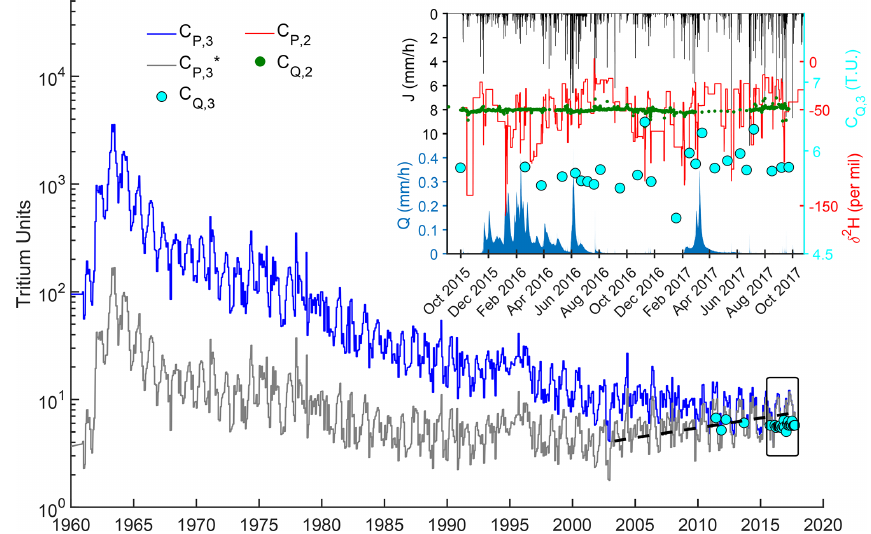
Figure 2. Data used in this study – 3 H in precipitation ( C P , 3 ), the corresponding tritium activities accounting for radioactive decay un- til 2017 ( C ∗ ), δ 2 H in precipitation C P , 2 (inset), precipitation J (inset), streamflow Q (inset), 3 H measurements in the stream ( C Q, 3 – both P , 3 plots), and δ 2 H in the stream ( C Q, 2 ; inset). The period contained in the inset is represented as a rectangle in the bigger plot. The dashed line visually represents the increasing trend in C ∗ that emerges as the effect of bomb peak tritium disappears (i.e., C P , 3 (t − T ) stops decreasing P , 3 (T,t) = C P , 3 (t − T )e − αT starts decreasing with increasing T ). approximately from the year 2000 on, so C ∗ P , 3